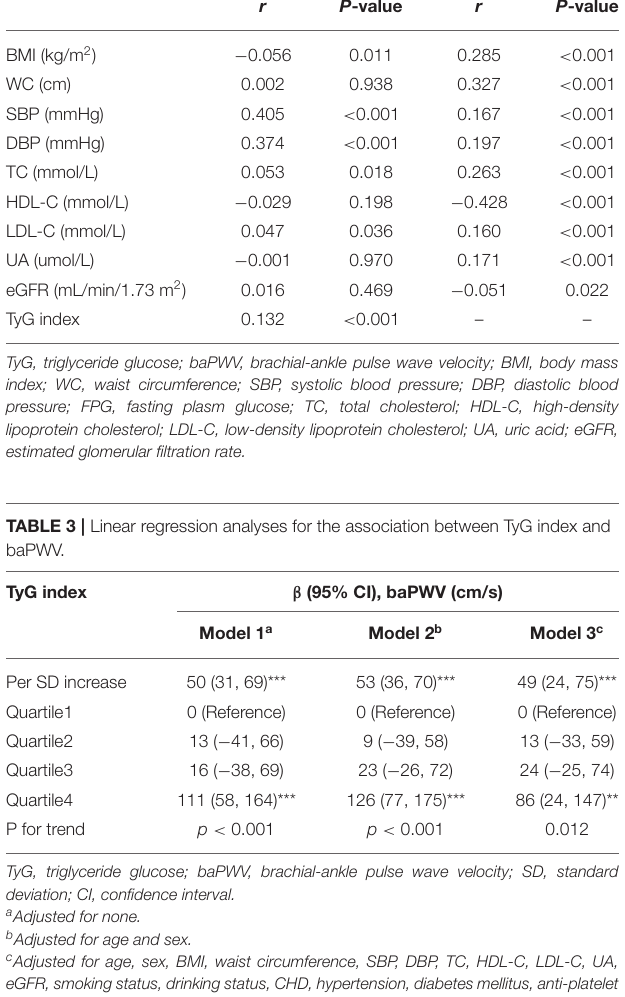
FIGURE 2 | Generalized additive model plot for the relationship of TyG index with baPWV (A) and high baPWV (B) after adjusted for age, sex, BMI, waist circumference, SBP, DBP, TC, HDL-C, LDL-C, eGFR, smoking status, drinking status, CHD, hypertension, diabetes mellitus, anti-platelet agents, anti-hypertensive agents, hypoglycemic therapy, and lipid-lowering